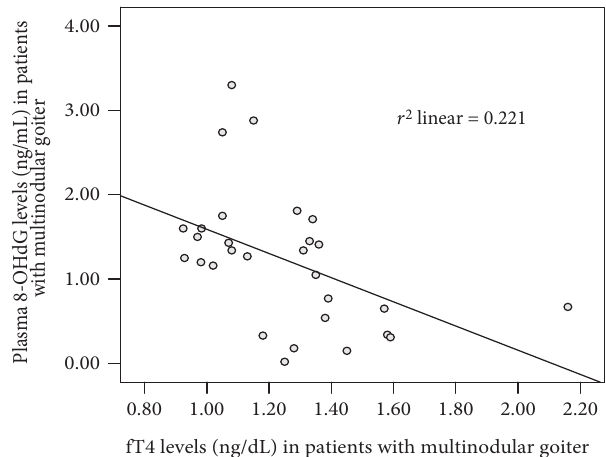
goiter2.202.001.801.601.401.201.000.80 fT4 levels (ng/dL) in patients with multinodular Figure 1: A negative correlation between fT4 and plasma 8-OHdG levels in patients with multinodular goiter ( p < 0 01